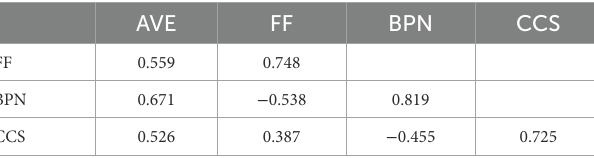
TABLE 5 Discriminant validity.